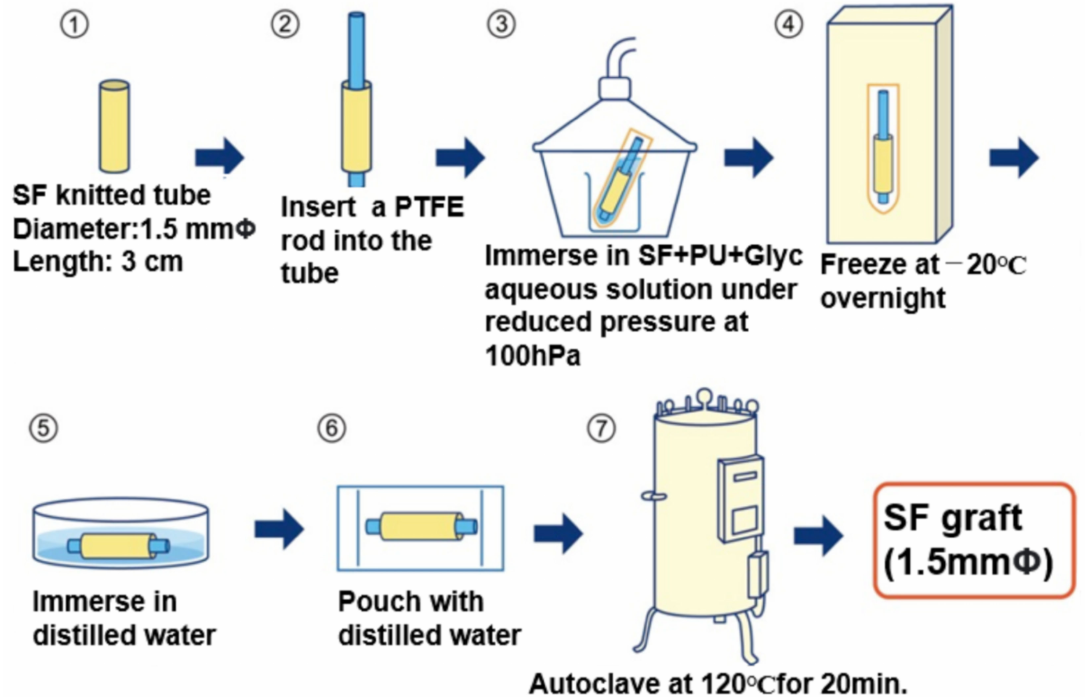
Figure 2. Preparation of SF vascular graft coated with a water-dispersed PU-SF composite